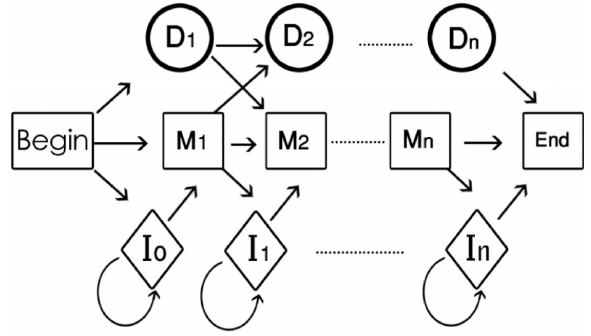
Figure 1. Plan 7 Construction.